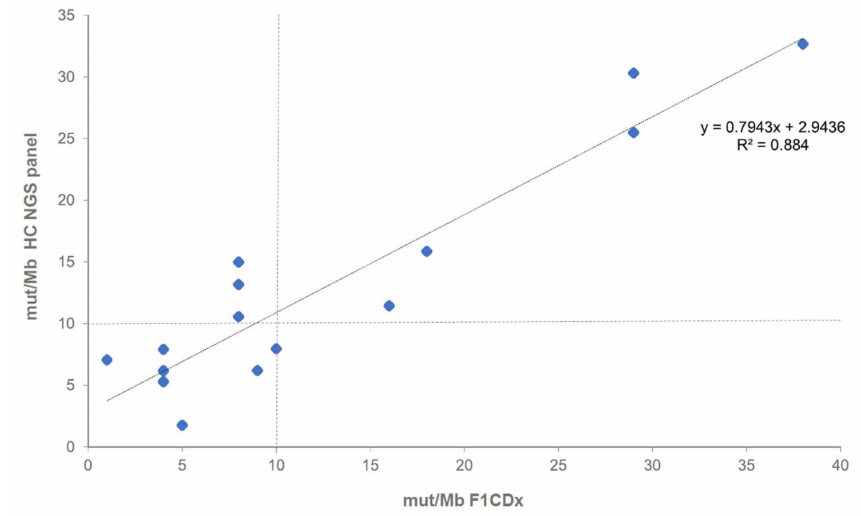
Figure 1. Correlation of TMB estimation of 17 samples measured by NEOplus v2 RUO ‡ and F1CDx